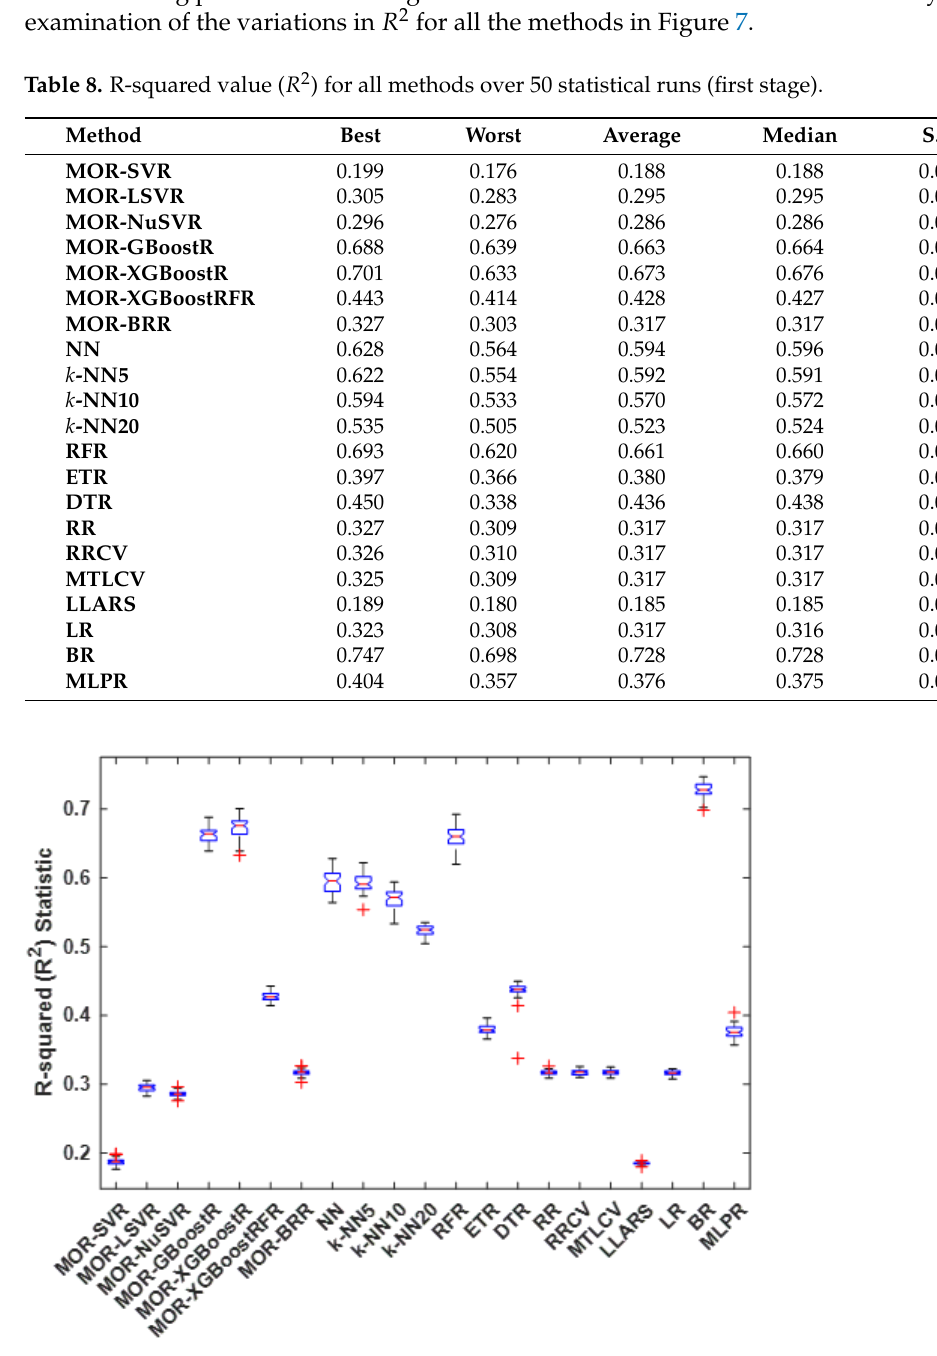
Figure 7. Box plots of R 2 statistic (over 50 statistical runs) for all methods for the first